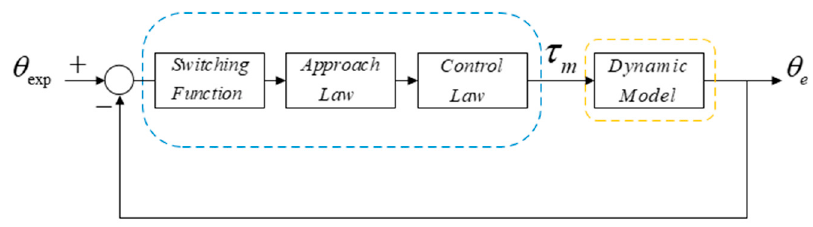
5 of 14 Figure 2. Schematic diagram of the NSA. 3. TSM Controller